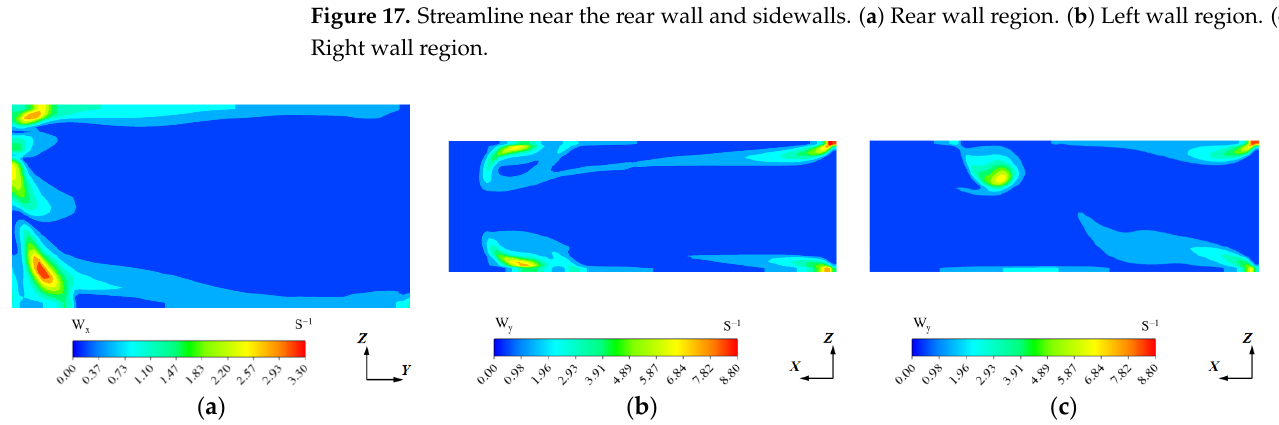
Figure 18. Vorticity intensity distribution near the rear wall and sidewalls. ( a ) Rear wall region. ( b ) Left wall region. ( c ) Right wall region.